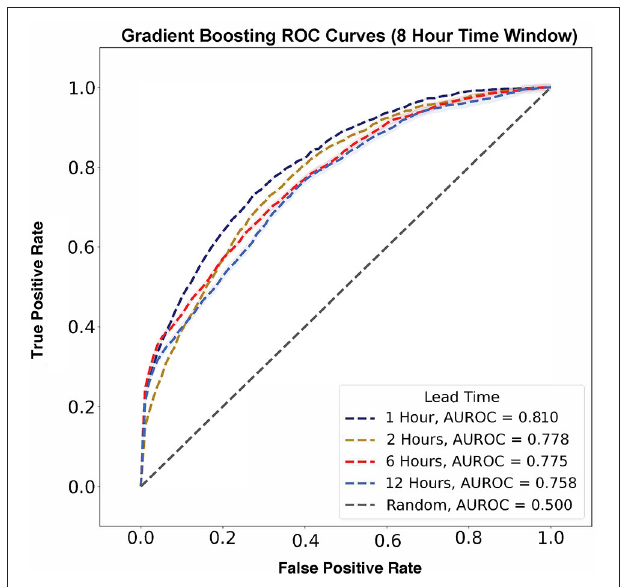
FIGURE 5 | Flow rate escalation ROCs with shaded 95% confidence interval bounds for gradient boosting algorithms with a time window of 8h. The model has its largest AUROC value of 0.810 at a lead time of 1h and decreases consistently as lead time